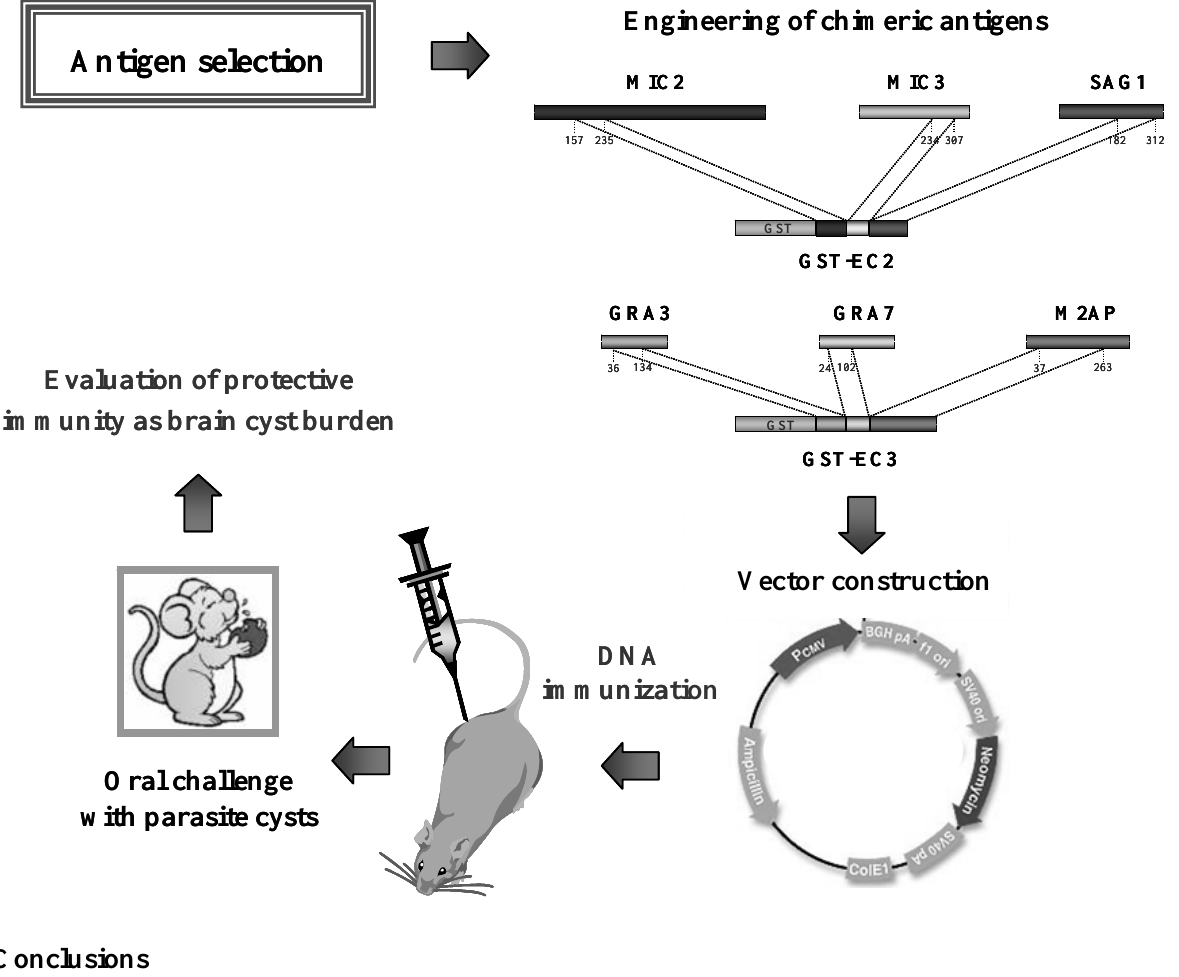
Figure 3. Engineering of chimeric antigens for DNA vaccine formulations used in animals against infection by Toxoplasma gondii